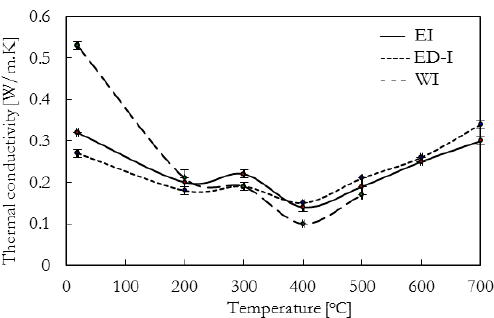
Figure 9. The thermal conductivity as a function of temperature of EI, ED-I, WI intumescent coatings (reproduced from [16]).